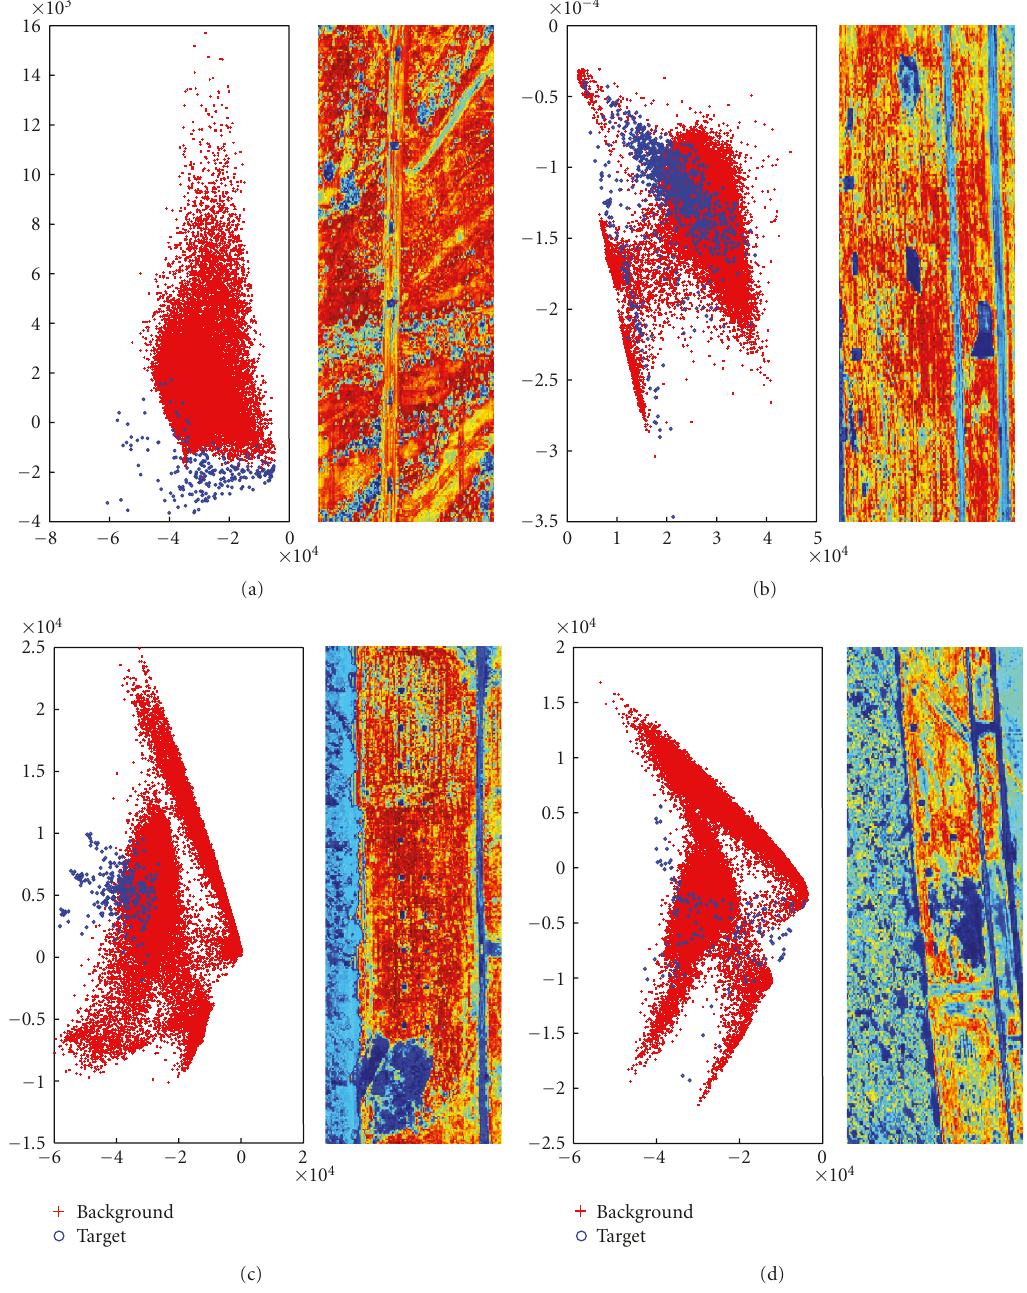
Figure 5: 2-D Principal Component Analysis view and SVDD pixel map. (a) ARES1D, (b) ARES1F, (c) ARES2F, (d) ARES3F. Note: Blue is target and red is background